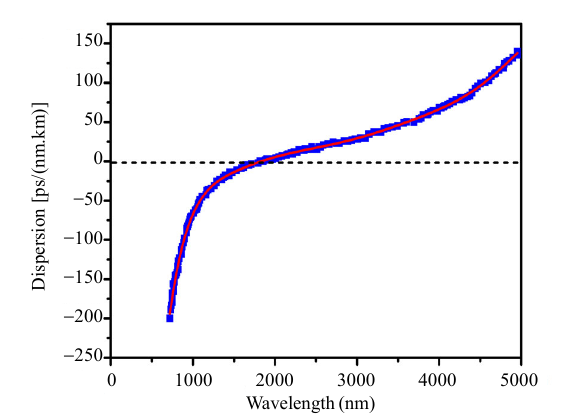
Fig. 2 Fitted dispersion data of the single-mode ZBLAN fiber.